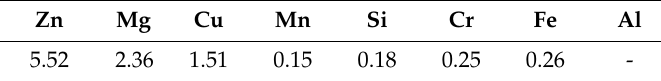
Table 1. Main composition of the 7075 aluminum alloy